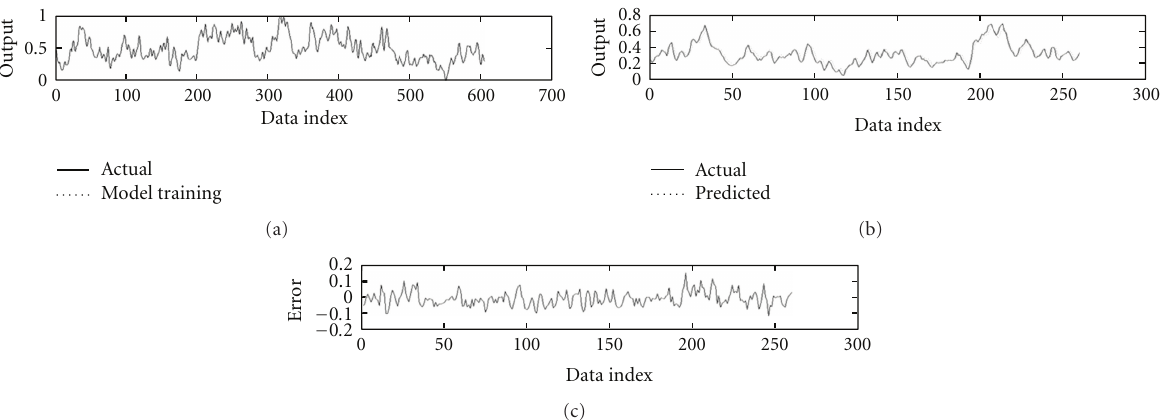
Figure 4: Plot of actual output and model output for training data set (uppermost plot) and plot of actual output and predicted output and the corresponding prediction error for industrial dryer data.